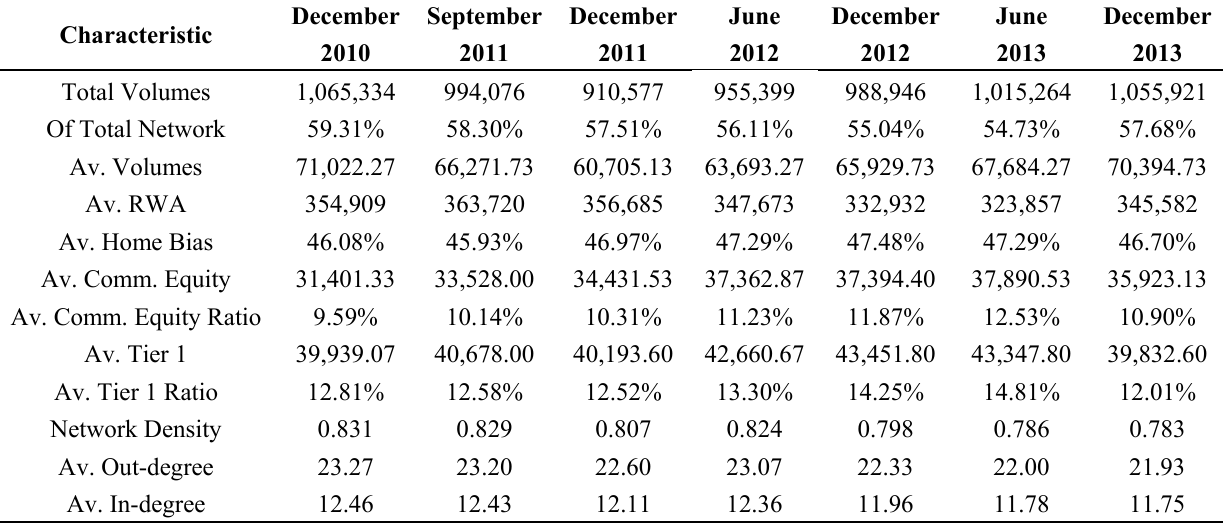
Table 2. Network Core